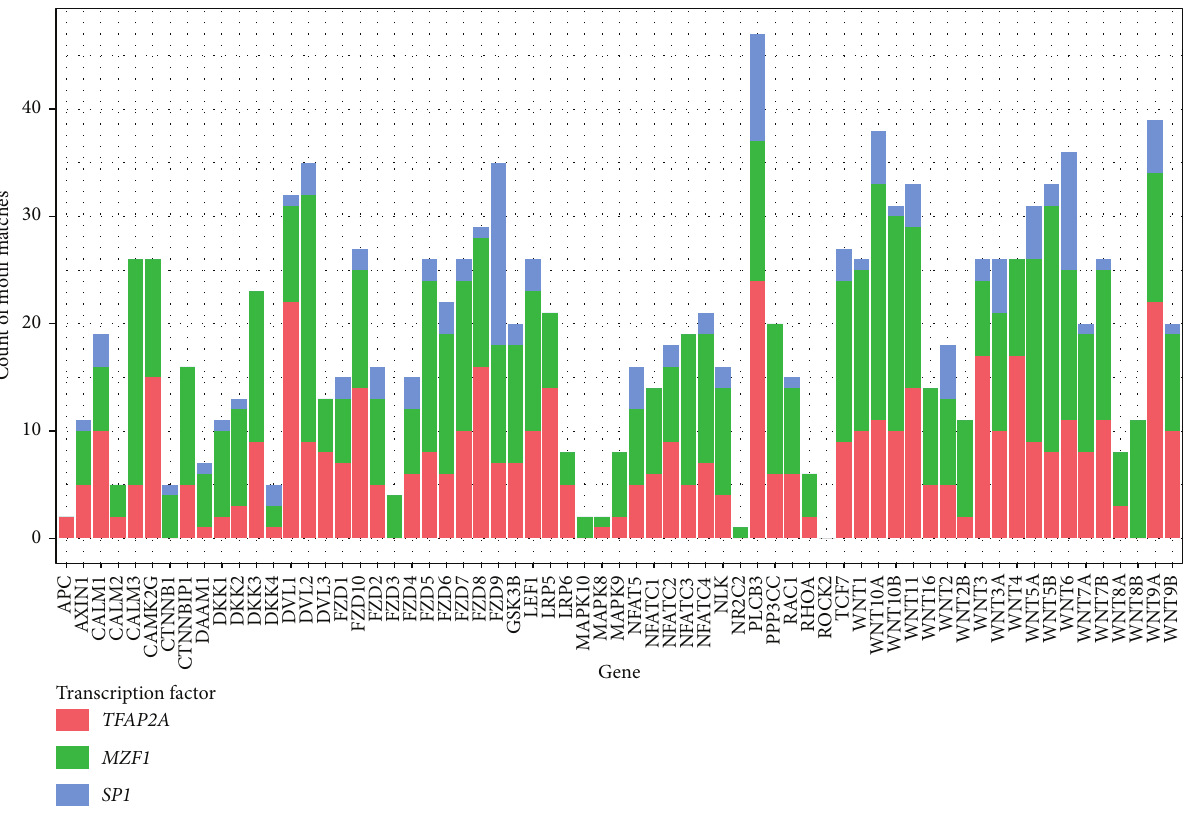
Figure 2: Total count for transcription factor binding site sequence motifs per WNT pathway gene. Red, green, and blue represent the counts for TFAP2A , MZF1 , and SP1 , respectively. Only those motifs identified with a confidence score greater than 95% were included.